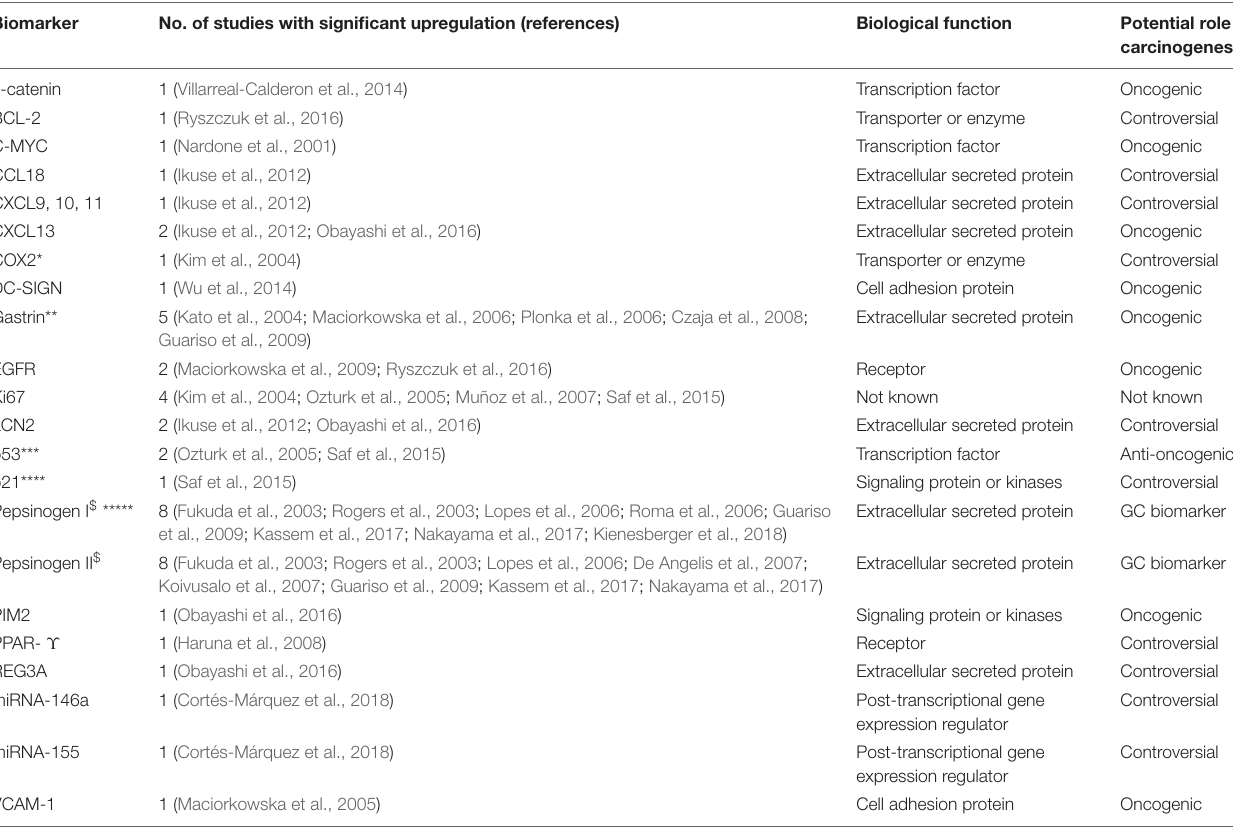
TABLE 1 | Biomarkers overexpressed in H. pylori infected children in at least one study included in this review.